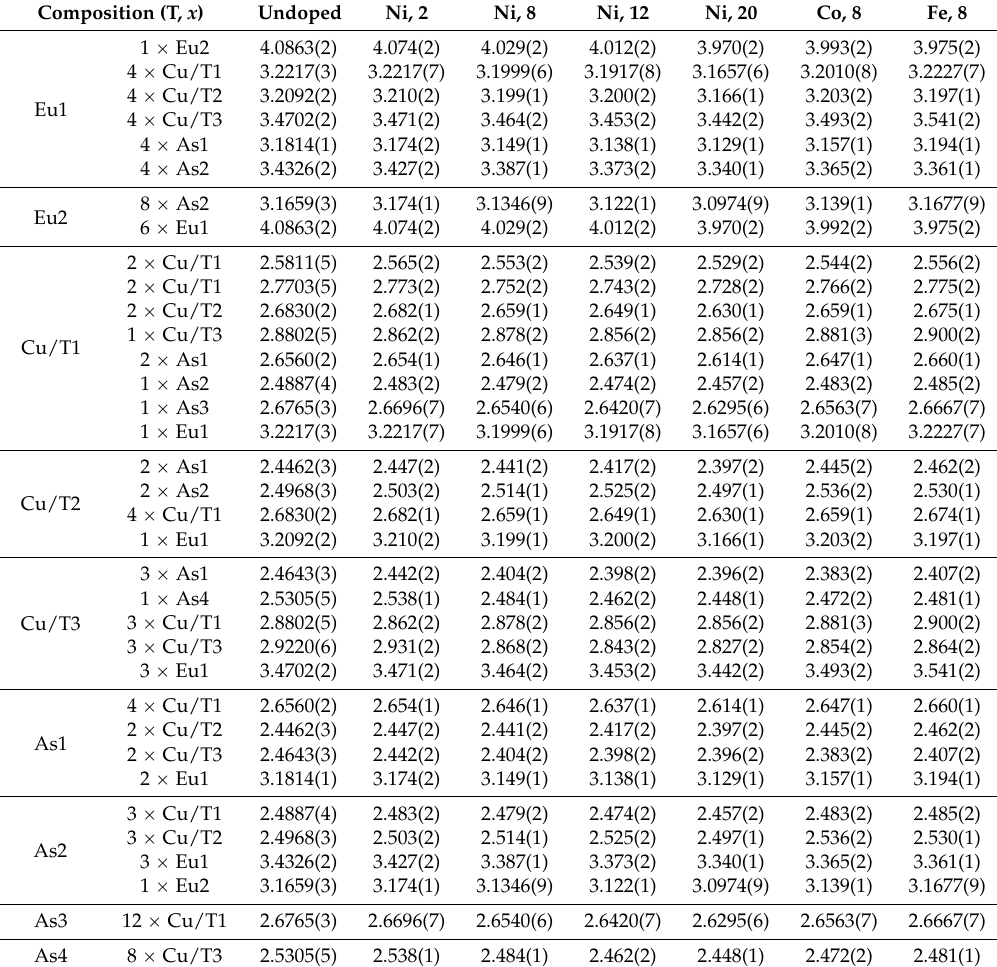
Table 4. Selected interatomic distances (in Å) for Eu 7 Cu 44 ´ x T x As 23 . Cu/T denotes a mixed site of Cu and T (T = Fe, Co,